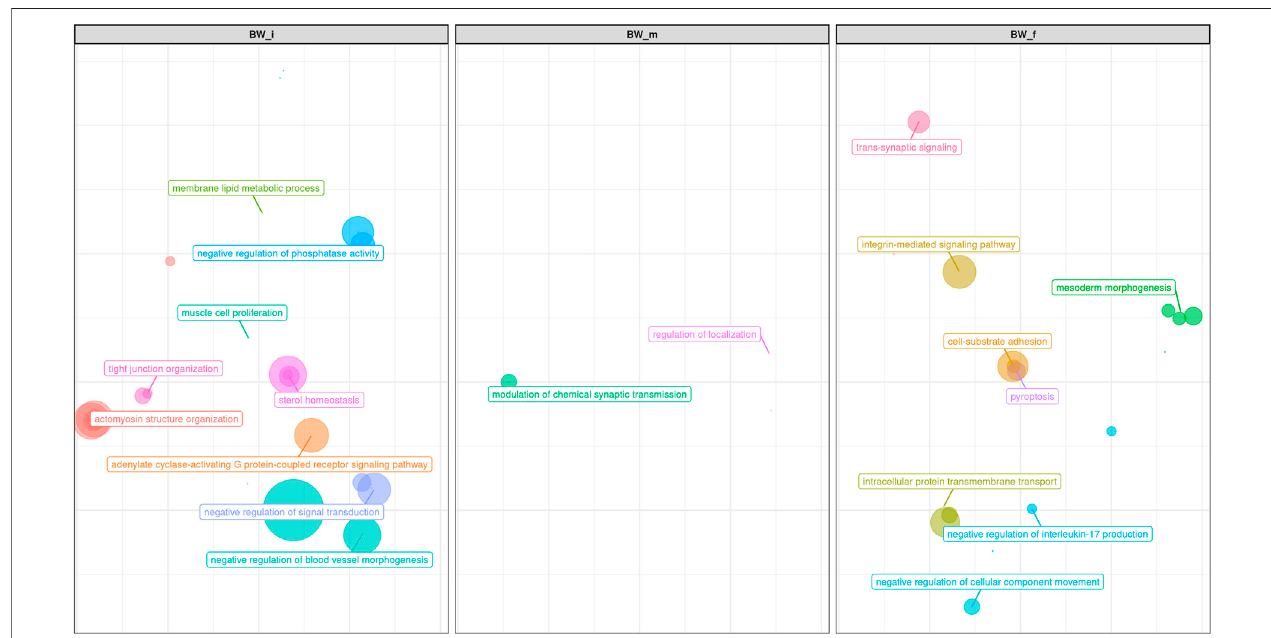
FIGURE8| Scatterplotrepresentingthemaingroupsofbiologicalpathwaysenriched forBodyWeighttraitsmeasured at fi rst,halfand fi nalperiod ofperformance test (BW_i, BW_m, BW_f); the area represents the number of pathways in that group, among the total. For a detailed list of the pathways enriched by these traits see Supplementary Figures S4A – C